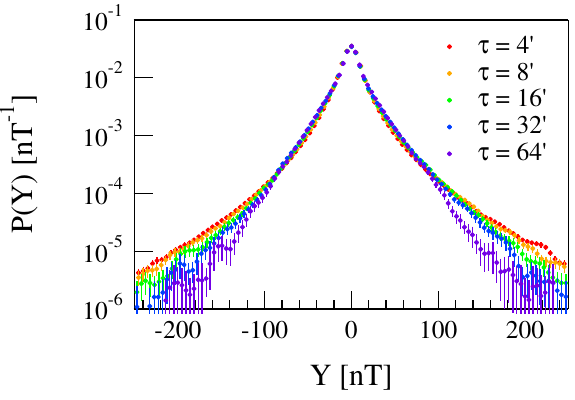
Fig. 1. The PDFs P ( δAE ; τ ) of the AE index increments δAE ( τ ) for τ = 4 , 8 ,..., 64 min.